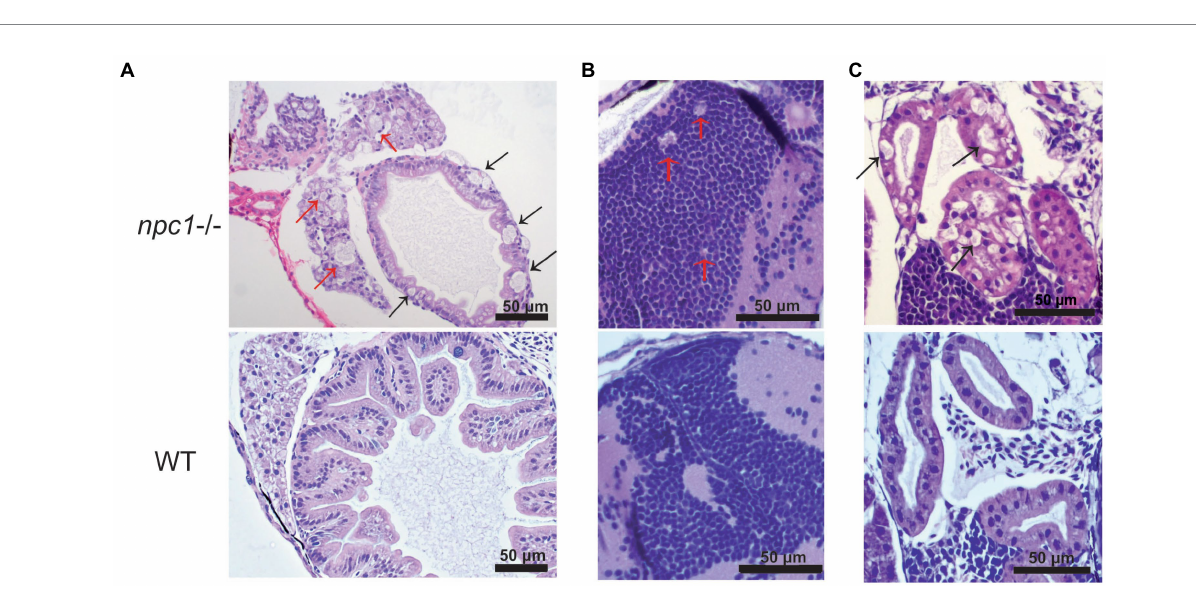
FIGURE 5 Alterations of different organs in npc1 − / − and wild type larvae of 3 wpf. (A) Intestine and liver. In npc1 − / − vacuolation in some enterocytes (intestine: black arrows) and hepatocytes (liver: red arrows) can be observed. (B) Gray matter. In npc1 − / − vacuolation in the brain gray matter is indicated with red arrows. (C) Renal tubules. In npc1 − / − cytoplasmic vacuolation of renal tubule epithelium is observed, some of the vacuoles are marked with black